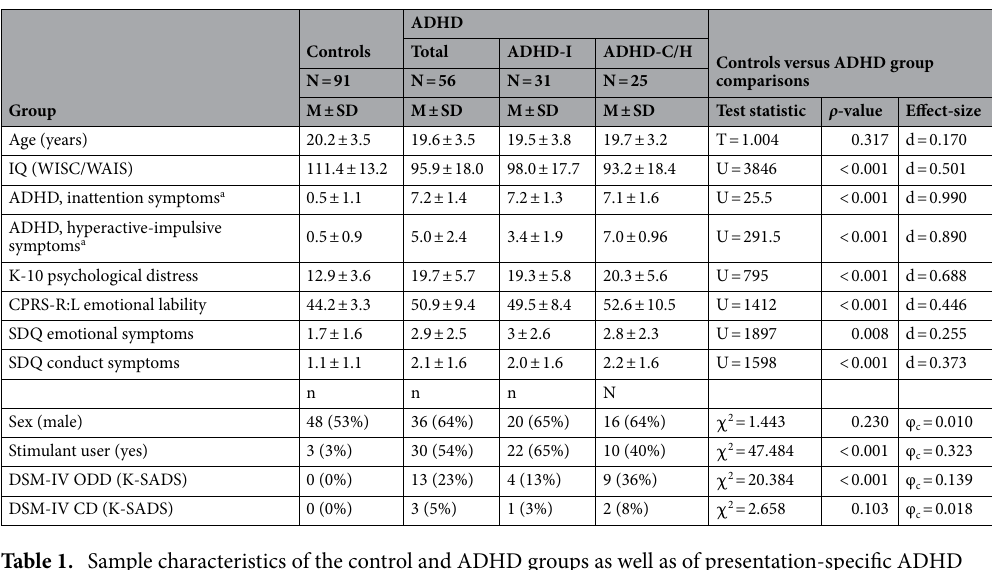
Table 1. Sample characteristics of the control and ADHD groups as well as of presentation-specific ADHD subgroups. Means between groups were compared with independent sample t-tests or Mann–Whitney-U- tests. Frequency distributions were compared with Pearson’s Chi-square ( χ 2 )-test. For the CPRS-R:L t-scores are presented, while for the SDQ and K-10 the questionnaire scores are given. ADHD = Attention Deficit/ Hyperactivity Disorder; ADHD-C/H: attention-deficit/hyperactivity disorder, combined or predominantly impulsive/hyperactive attention-deficit/hyperactivity disorder; ADHD-I: predominately inattentive attention-deficit/hyperactivity disorder; CD = Conduct Disorder; CPRS-R:L = Conners’ parent rating scale, revised, long version; DSM-IV = Diagnostic and Statistical Manual of Mental Disorders, 4th Edition; HC = Healthy Controls; IQ = Intelligence Quotient; K-SADS = Kiddie Schedule for Affective Disorders and Schizophrenia; K-10 = Kessler Psychological distress scale, NESDA version; N = number of participants; n = number of participants within subgroups; ODD = Oppositional Defiant Disorder; SD = Standard Deviation; SDQ = Strength and Difficulties Questionnaire; WAIS: Wechsler Adult Intelligence Scale; WISC: Wechsler Intelligence Scale for Children. a Combined symptom counts were derived from DSM-IV subscales of K-SADS and the Conners’ rating